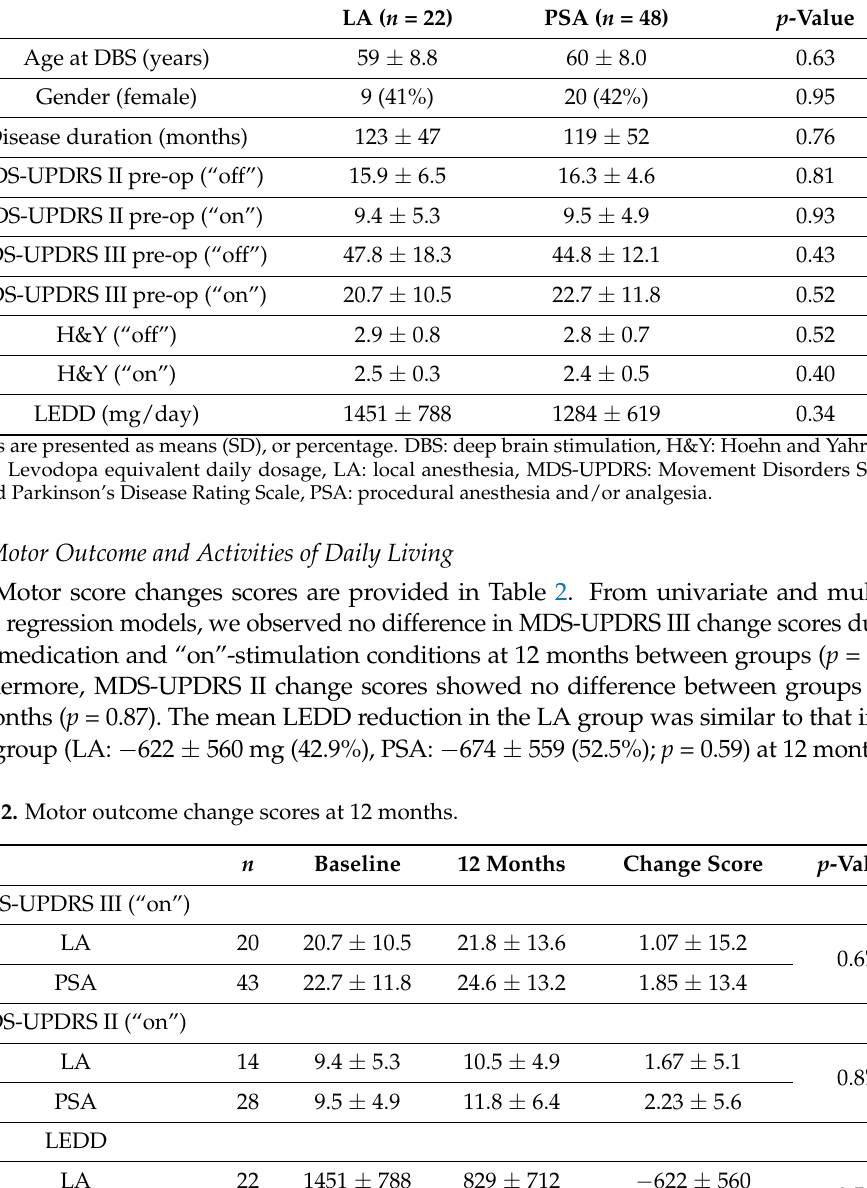
Table 1. Baseline patient characteristics: local anesthesia versus procedural anesthesia and/or analgesia.